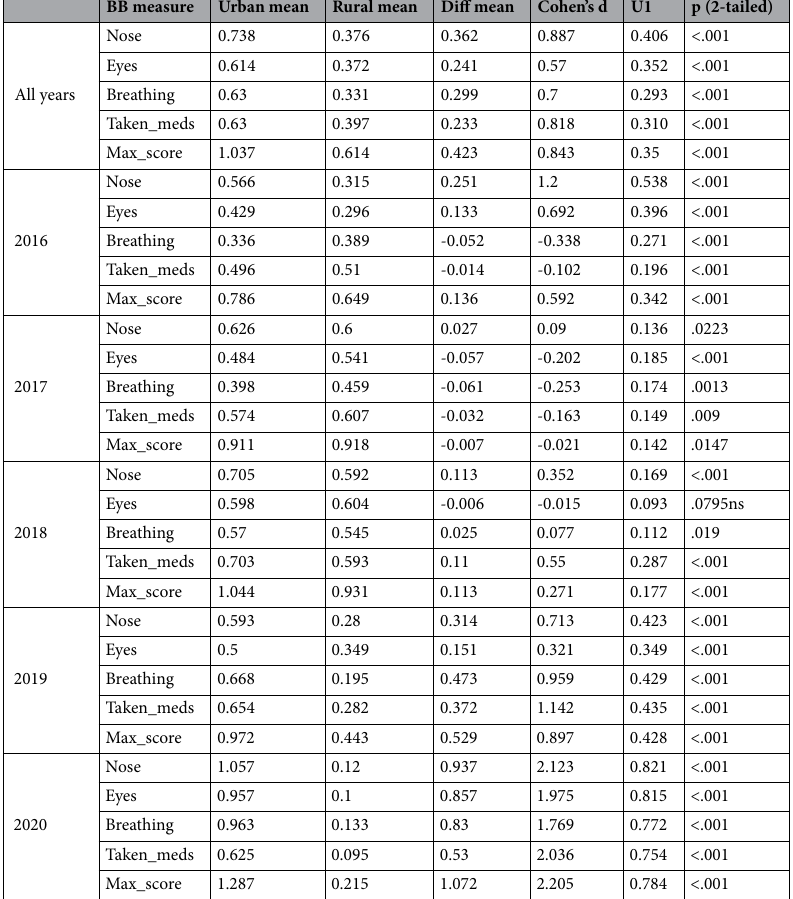
0.05 are marked as ns